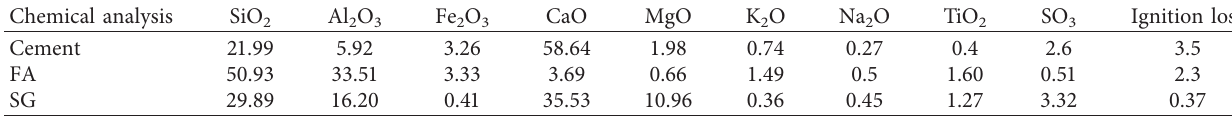
Table 1: Chemical composition of cementing materials (wt.%).